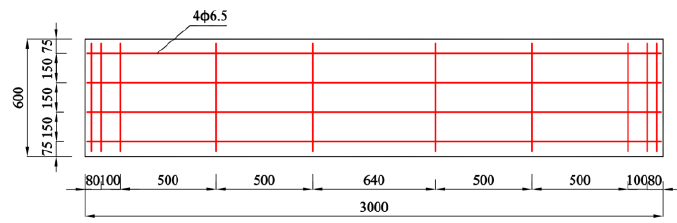
Figure 2. Schematic of the AACP (units: mm).